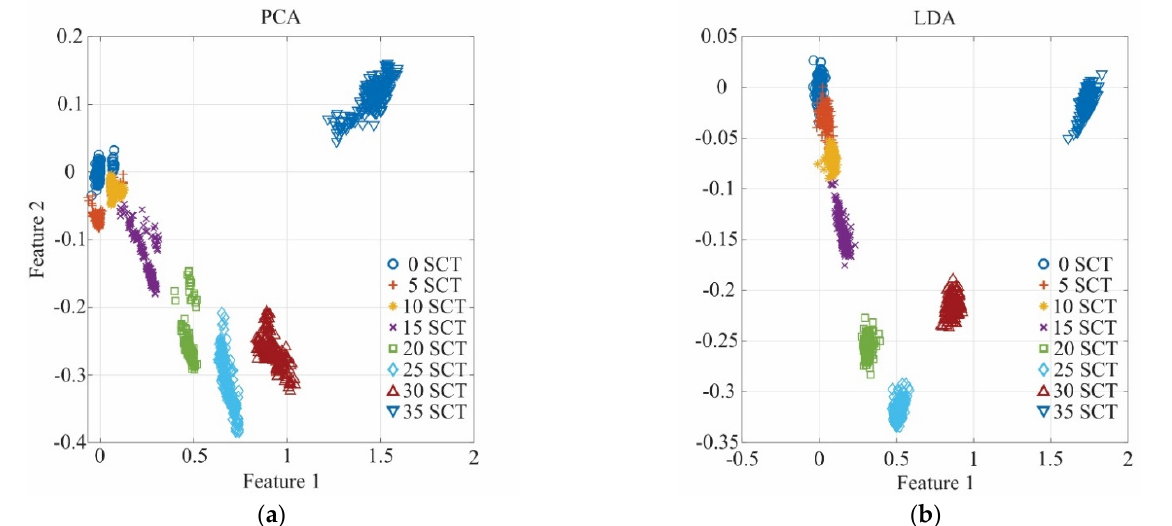
Figure 10. Performance comparison between ( a ) PCA transformation and ( b ) LDA transformation.